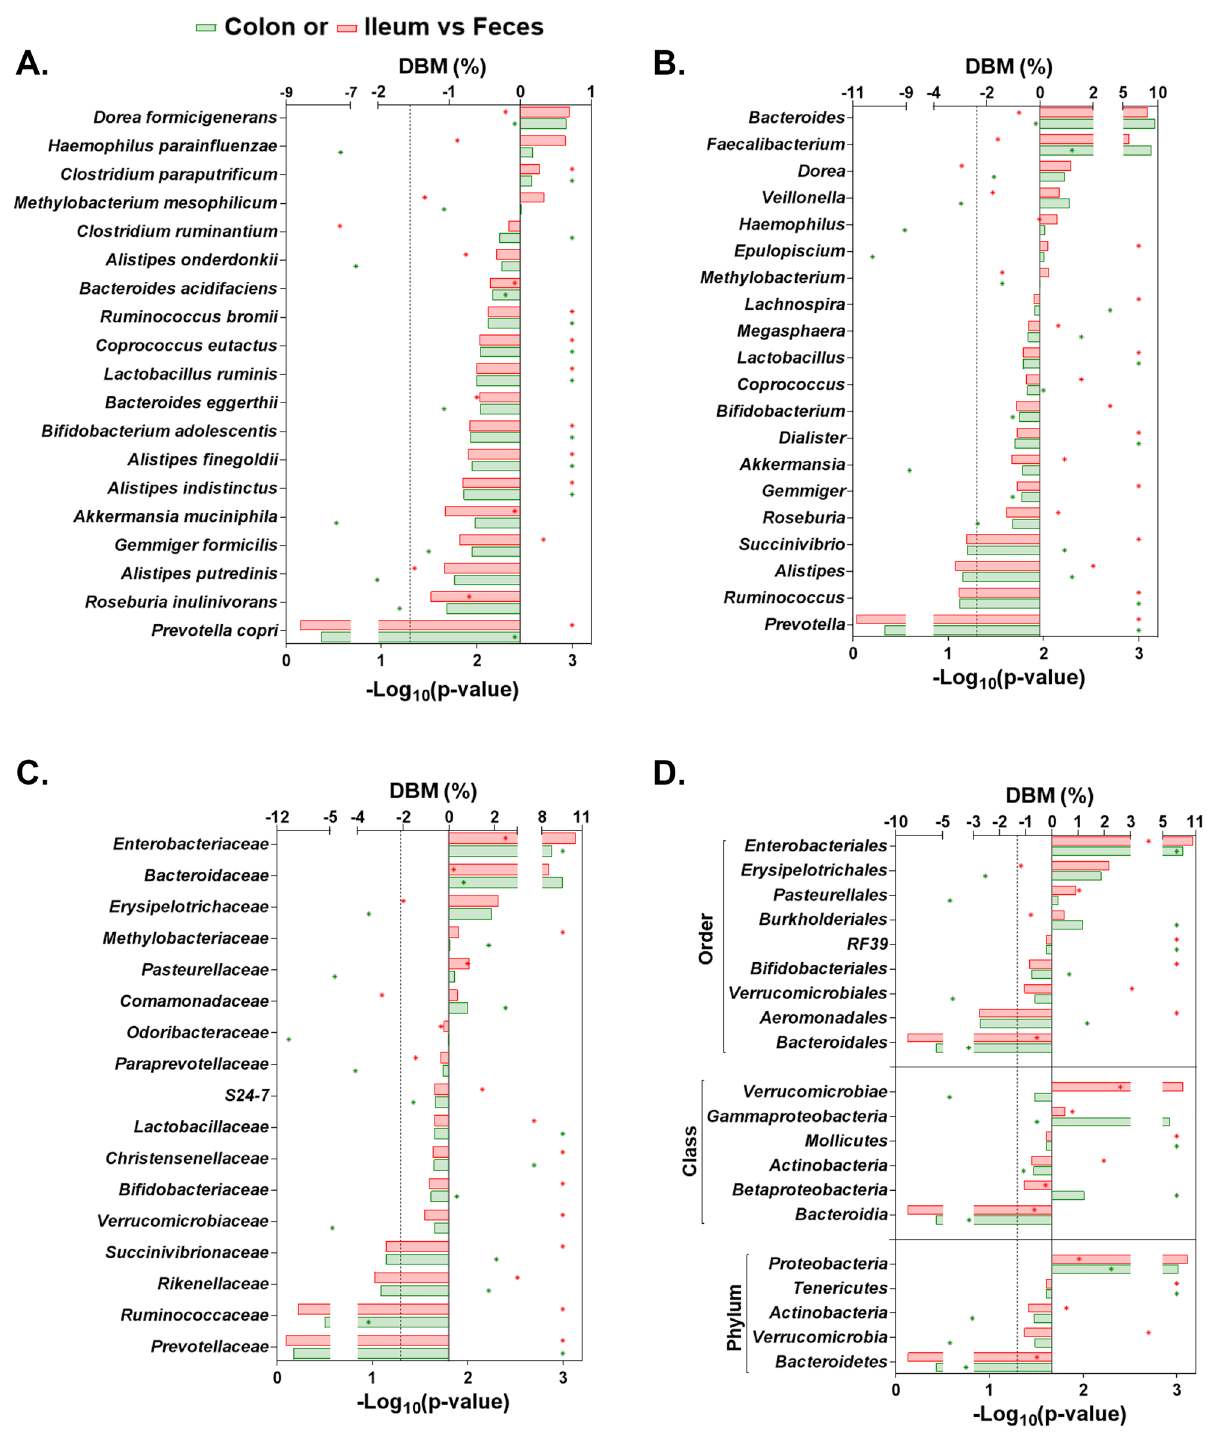
Figure 3. Colon and ileum present a signature bacteria composition with some taxa overrepresented in these regions of the GI tract. Difference between mean relative abundance (DBM, top x -axis), for colon (green) or ileum (red) against feces are represented as bars. Positive values indicate those taxa overrepresented in colon or ileum, and negative indicate those overrepresented in feces. Asterisks correspond to p-values (bottom x -axis) for White’s non-parametric t-test. Taxa showing DBM > 0.2% and p-value < 0.05 for at least one paired comparison (ileum or colon vs. feces), were included in the plots. ( A ) Species classification. ( B ) Genus. ( C ) Family. ( D ) Order, class and